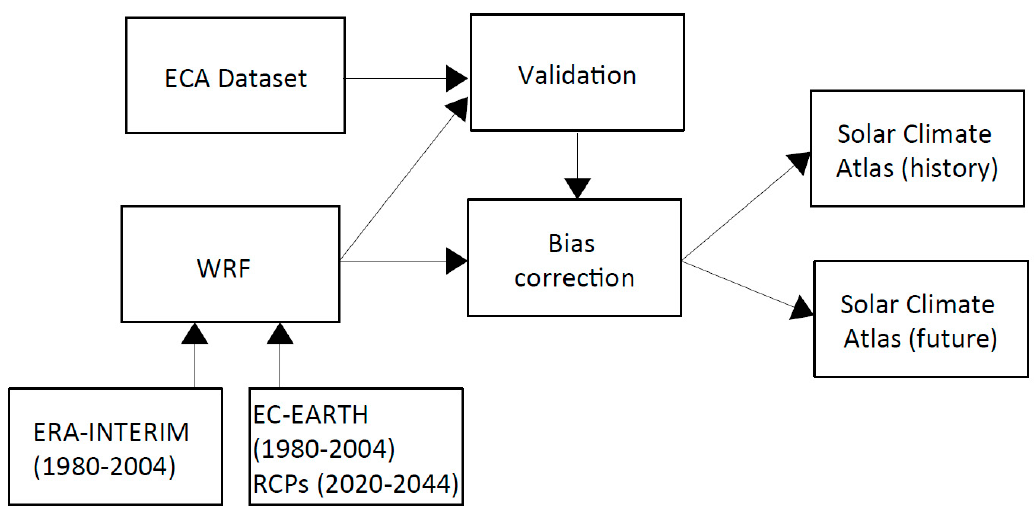
Figure 1. Flow process of the implemented methodology for the high-resolution solar climate atlas under climate change.